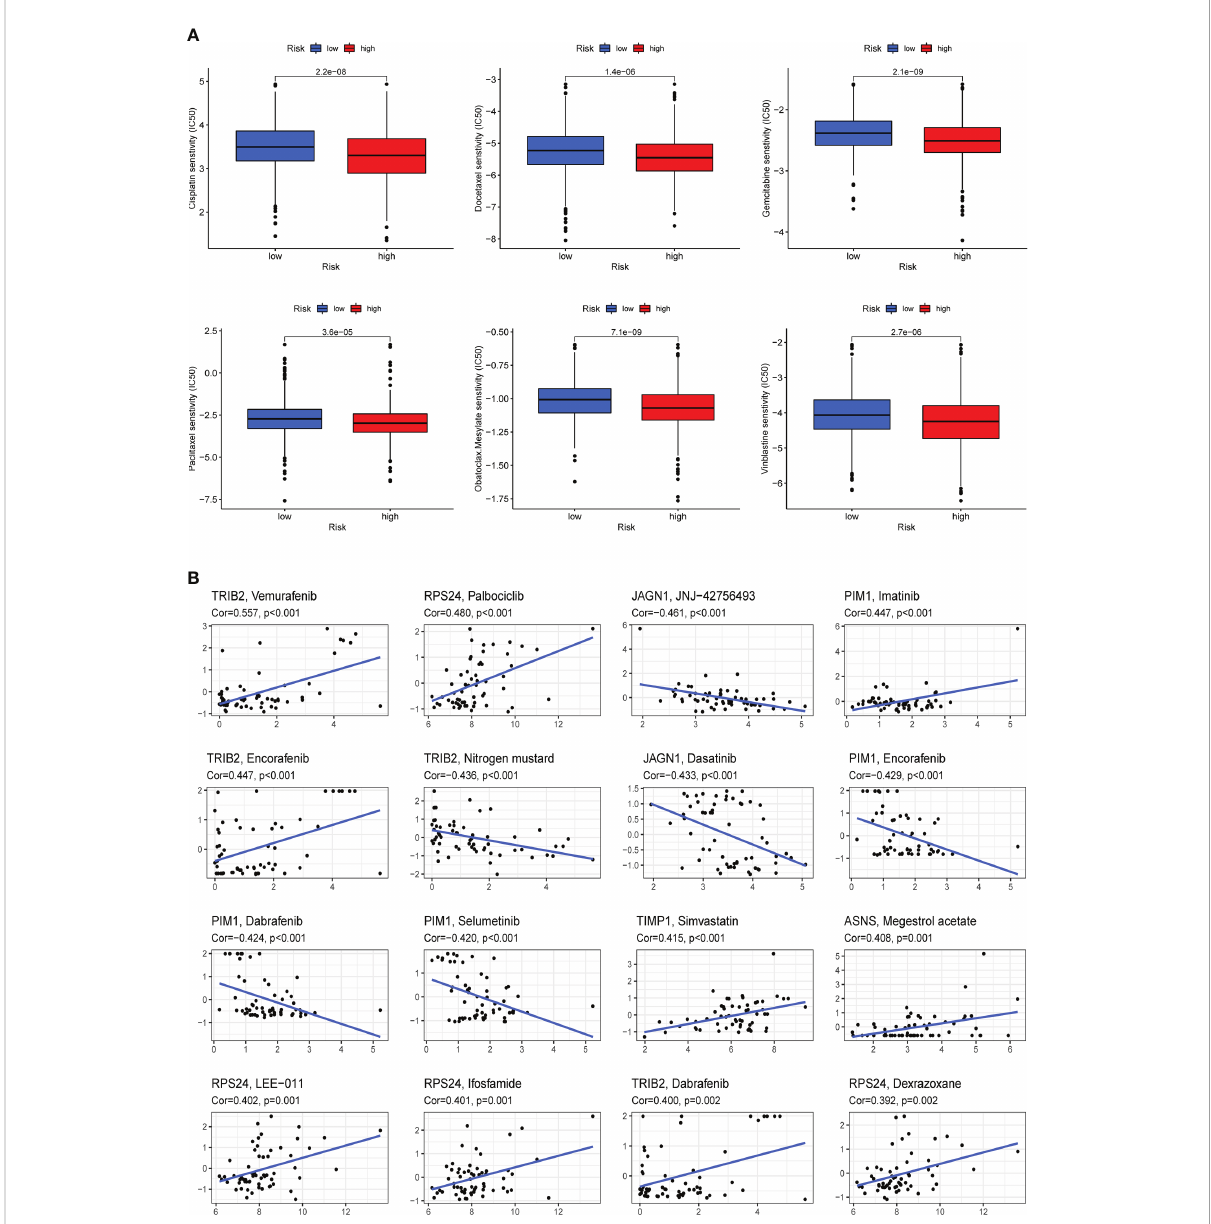
FIGURE 9 Drug sensitivity analysis. (A) Cisplatin, Docetaxel, Gemcitabine, Paclitaxel, Obatoclax.mecylate, and Vinblastine were observed to have lower IC50 values in the high-risk group, that is, the high-risk group was more sensitive to these drugs. (B) Analysis of the correlation between the expression of eight candidate genes included in the risk score model and chemotherapy drug